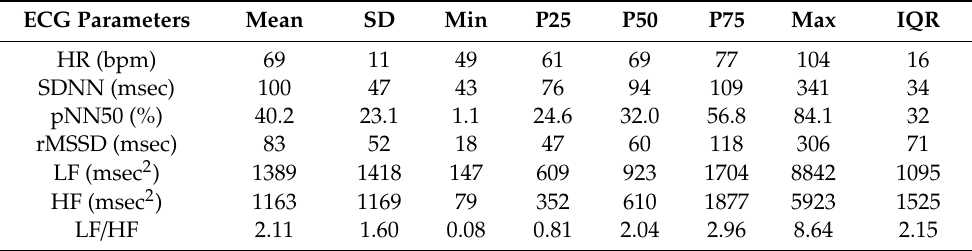
Table 1. Baseline descriptive cardiovascular measurements 1